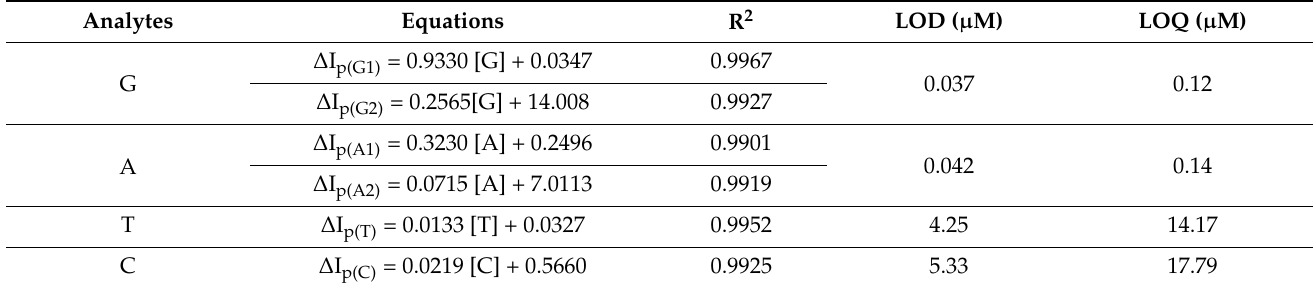
Table 2. Equations representing the linear plots for the four DNA bases along with their regression coefficients, LODs, and LOQs. ∆ I p refers to the current after background